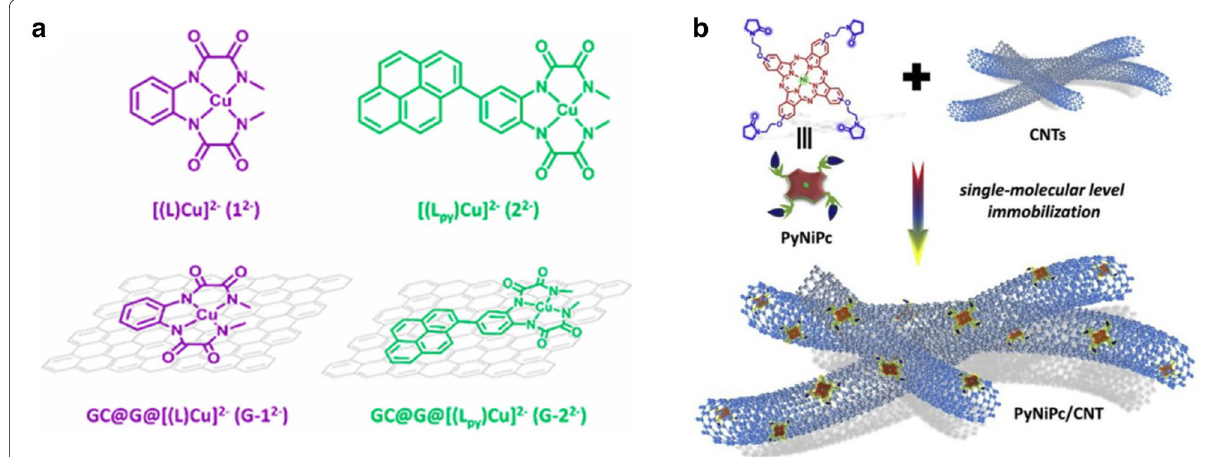
Fig. 8 Adsorption of molecular catalysts on a the basal plane of graphene and b CNTs. Copyright permissions from Elsevier and ACS [133, 135]